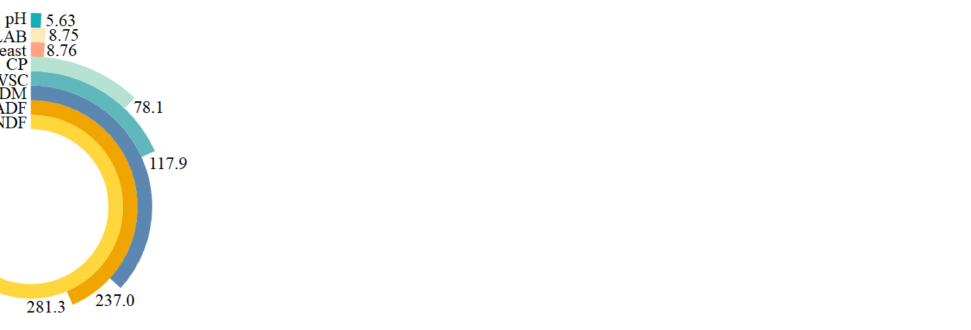
Figure 1. Fresh corn and its chemical and microbial composition; ADF: acid detergent fiber [g/kg DM] (DM = dry matter [g/kg]), ADL: Acid detergent lignin [g/kg DM], CP: crude protein [g/kg DM]; LAB: lactic acid bacteria [log cfu/g], NDF: neutral detergent fiber [g/kg DM], WSC: water soluble carbohyrate [g/kg DM], yeast [log